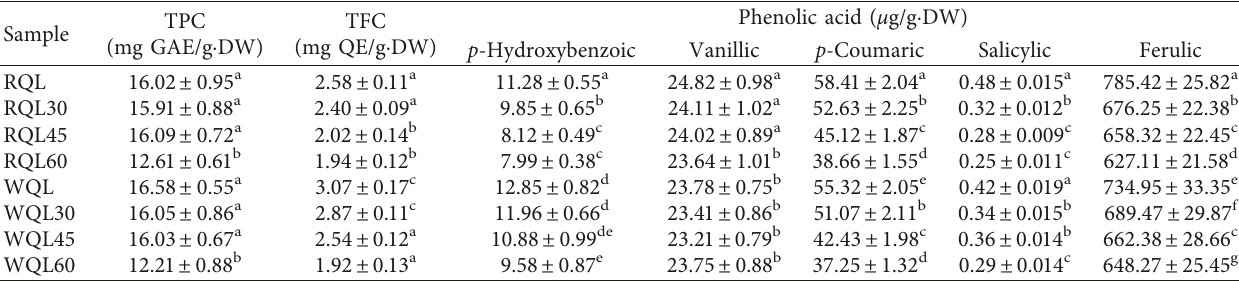
Table 2: Total phenolics content (TPC), total flavonoids content (TFC), and phenolic acids profile of red and white quinoa leaves dried in different temperatures.